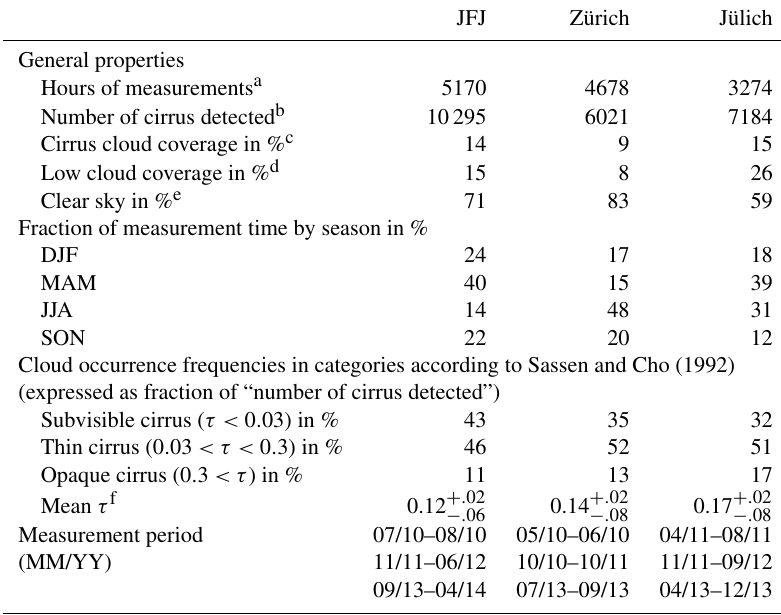
Table 2. Properties of the cirrus clouds detected between 2010 and 2014.